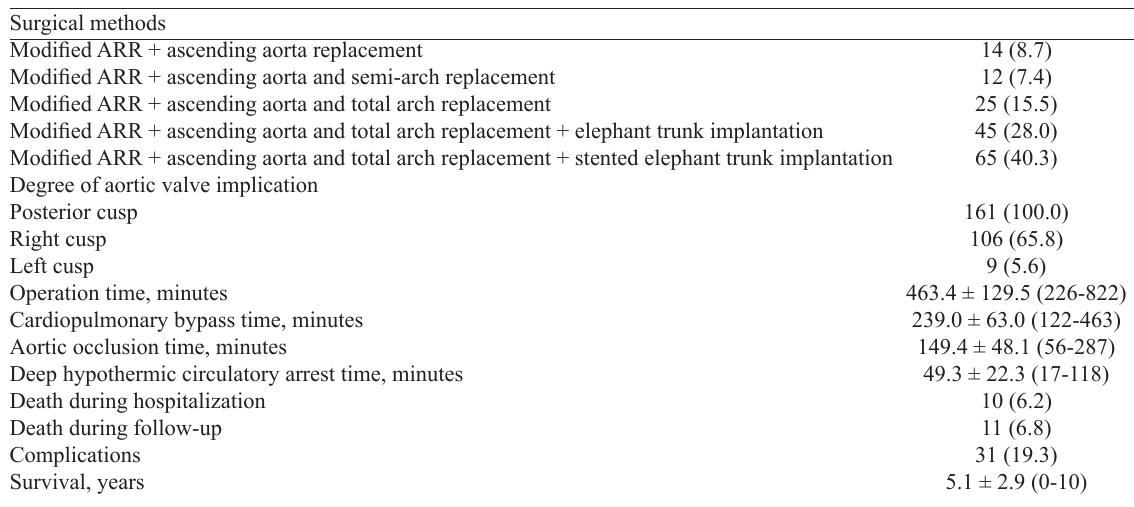
Table 2. Surgical methods and perioperative details (N=161).